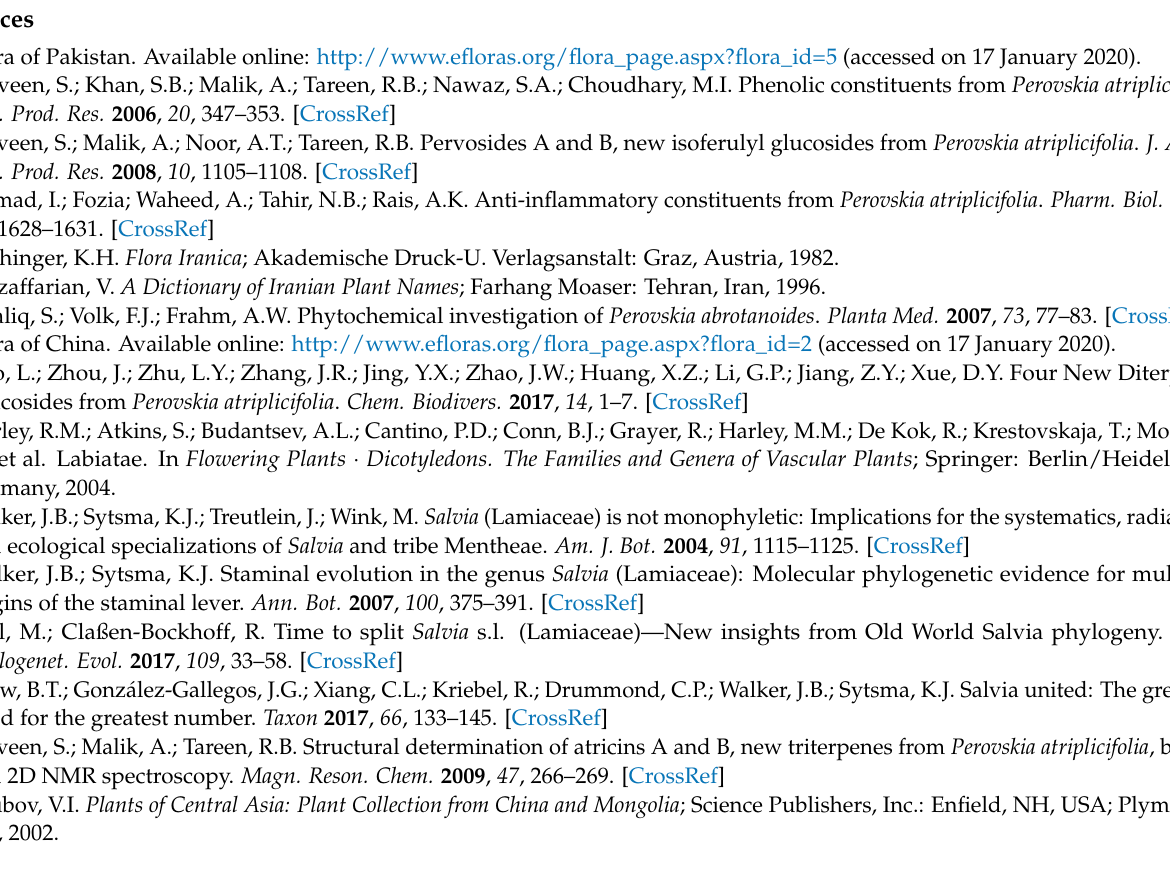
Figure A1. Plants growing at the site of the experiment: Salvia yangii ( a ), Salvia abrotanoides ( b ) and mature leaves with fragments of inflorescence of Salvia yangii ( c ), Salvia abrotanoides ( d ); all photographs are from the collection of the Botanical Garden of Medicinal Plants,